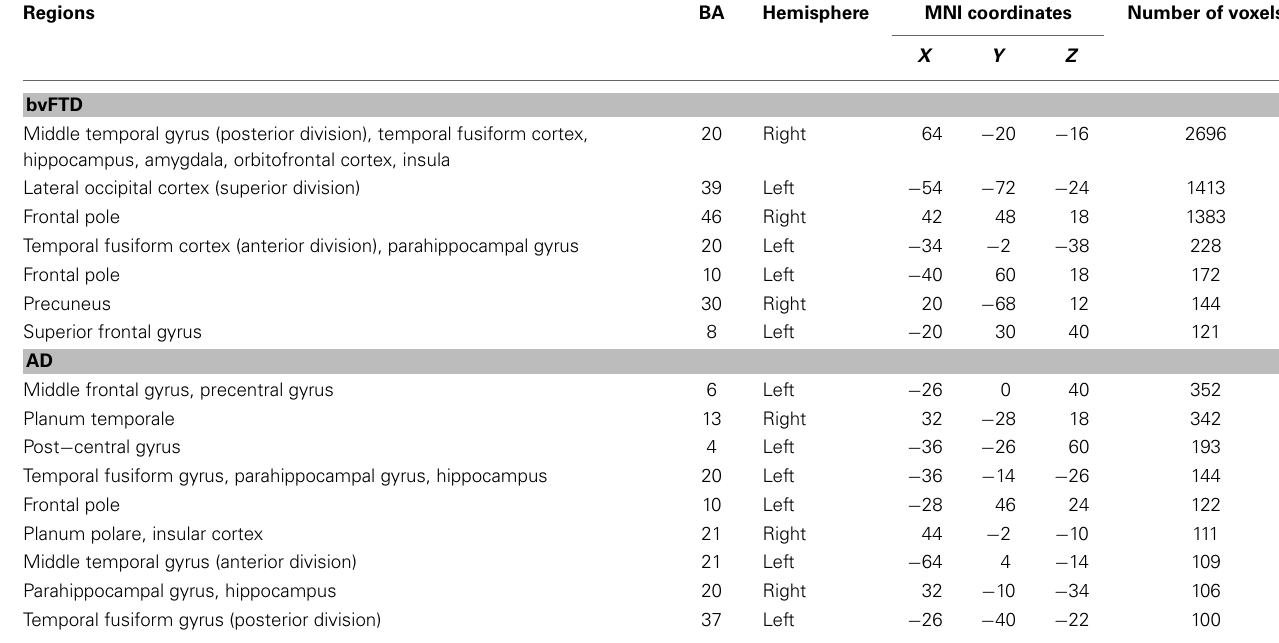
Table 5 | Voxel-based morphometry results showing regions of significant gray matter intensity decrease that covary with emotional enhancement of memory in bvFTD and AD at p < 0.005, uncorrected for multiple comparisons. Regions BA Hemisphere MNI coordinates